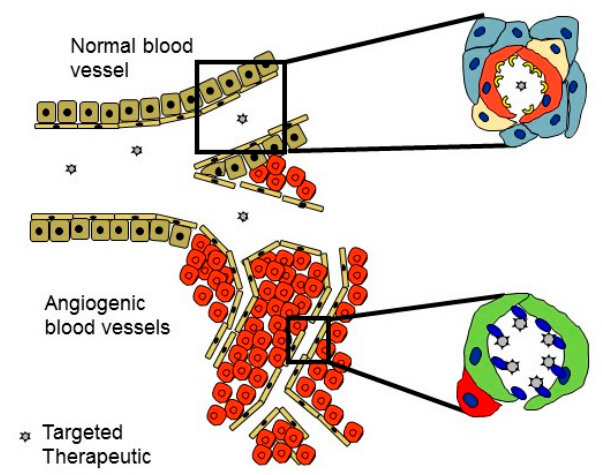
Figure 2. Target organ-specific delivery of therapeutics in regenerative medicine. The angiogenic blood vessels that form in regenerating tissues after injury are structurally and molecularly different from the dormant blood vessels elsewhere in the body. They provide an accessible and abundant target for the organ-specific delivery of therapeutics during the repair of the tissue injuries. They can be targeted by vascular homing peptides that bind to their receptor selectively expressed only in angiogenic blood vessels. Drugs administered systemically can be converted to target tissue-specific by coupling them to the vascular homing peptide.